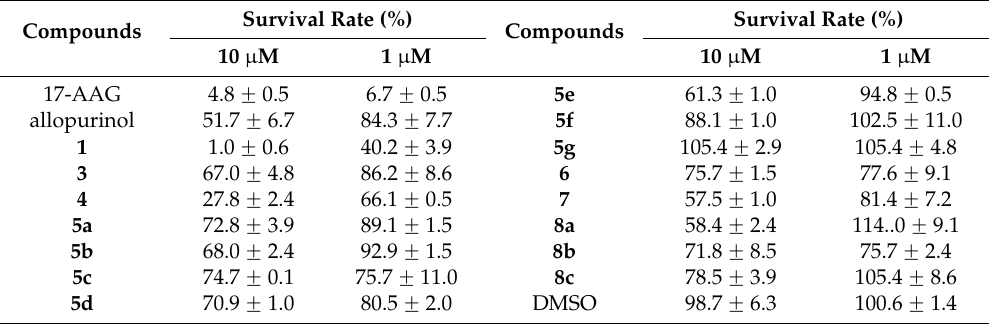
Table 2. In vitro activity of allopurinol derivatives against MDA-MB-231 cell assays. Survival Rate (%) Compounds